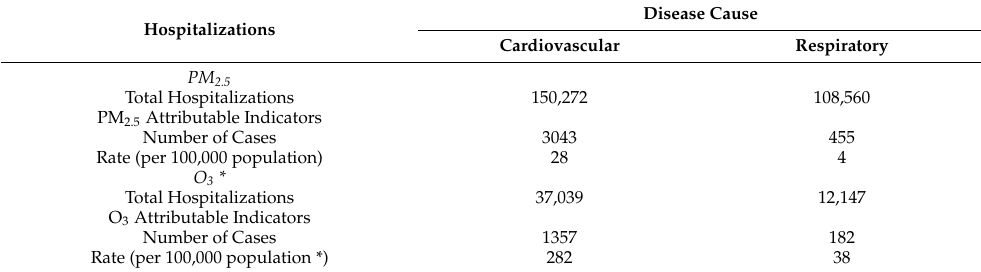
Table 6. Short-term impacts of air pollution on daily hospitalizations.